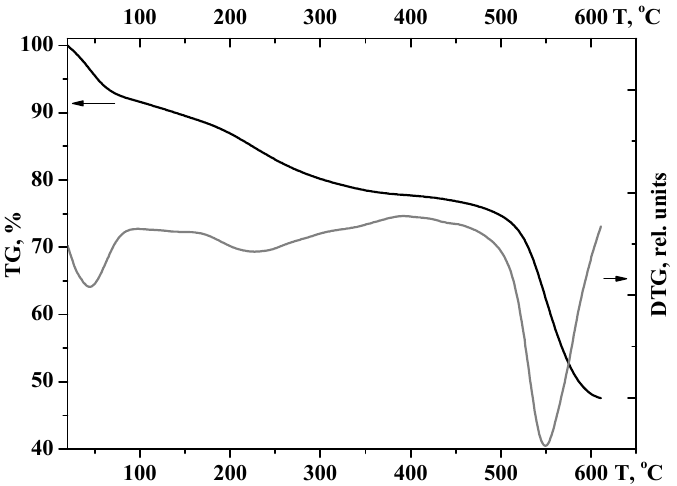
Figure 4. Thermogravimetric data for UiO-66, as synthesized (heating rate of 10 °C·min − 1 ).